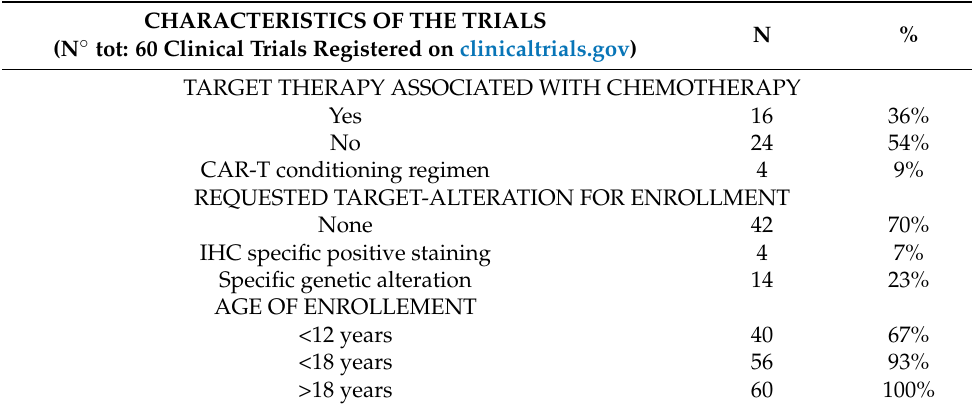
Table 3. Cont. CHARACTERISTICS OF THE TRIALS (N ◦ tot: 60 Clinical Trials Registered on